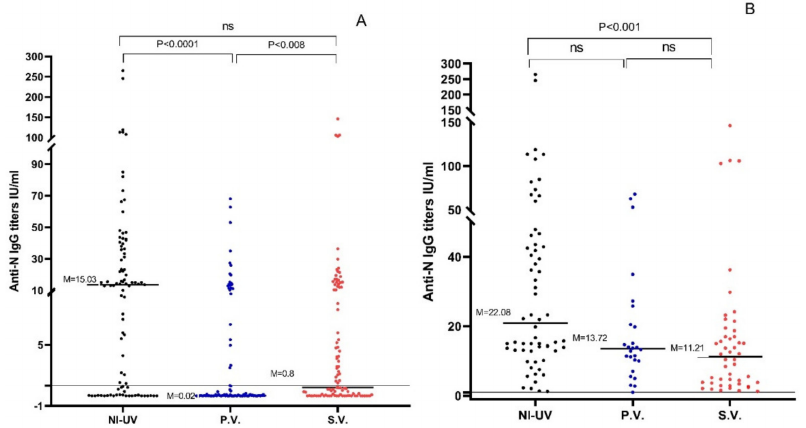
Figure 2. ( A ) Anti-N IgG titers in the 3 studied groups for all participants. ( B ) Anti-N IgG titers in the 3 studied groups after excluding seronegative samples. NI-UV: Naturally Infected Unvaccinated, P.V.: Pfizer Vaccinated, S.V.: Sinopharm Vaccinated, M: Median, ns: Nonsignificant ( p >